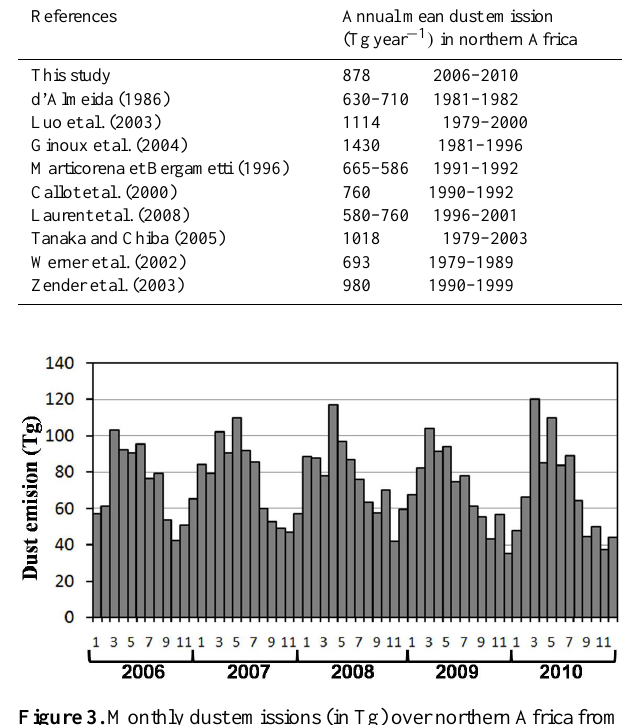
Figure 3. Monthly dust emissions (in Tg) over northern Africa from 2006 to